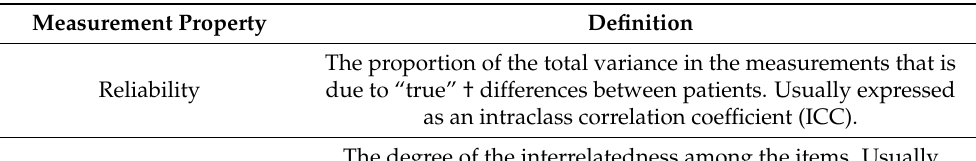
Table 1. COSMIN definitions of domains, measurement properties, and aspects of measurement